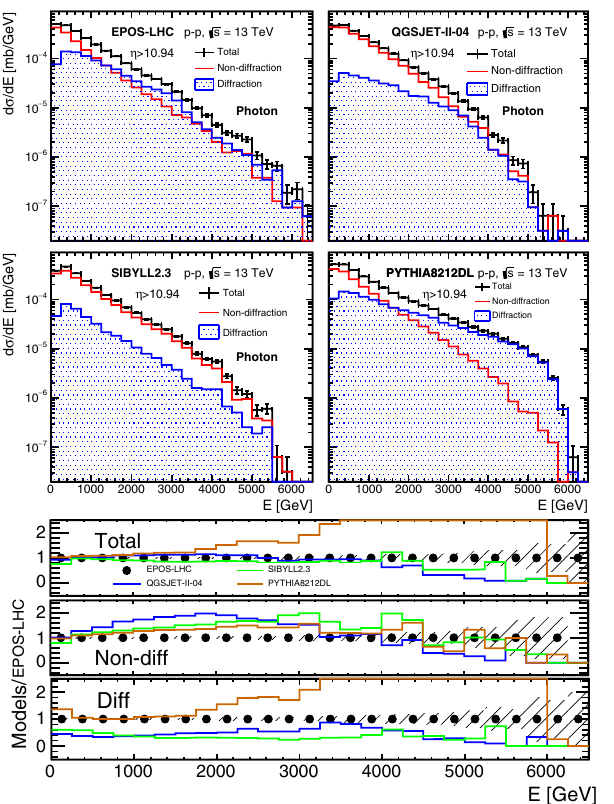
Fig. 3 Photon spectra at η > 10 . 94 ( left ) and 8 . 81 < η < 8 . 99 ( right )( topfourpanelsineachset ).ThesearegeneratedbyEPOS-LHC, QGSJET-II-04, SYBILL 2.3, and PYTHIA 8212DL, respectively. The total photon spectra ( black ) were classified by nondiffraction ( red ) and diffraction ( blue ) according to MC true flags. The bottom three plots